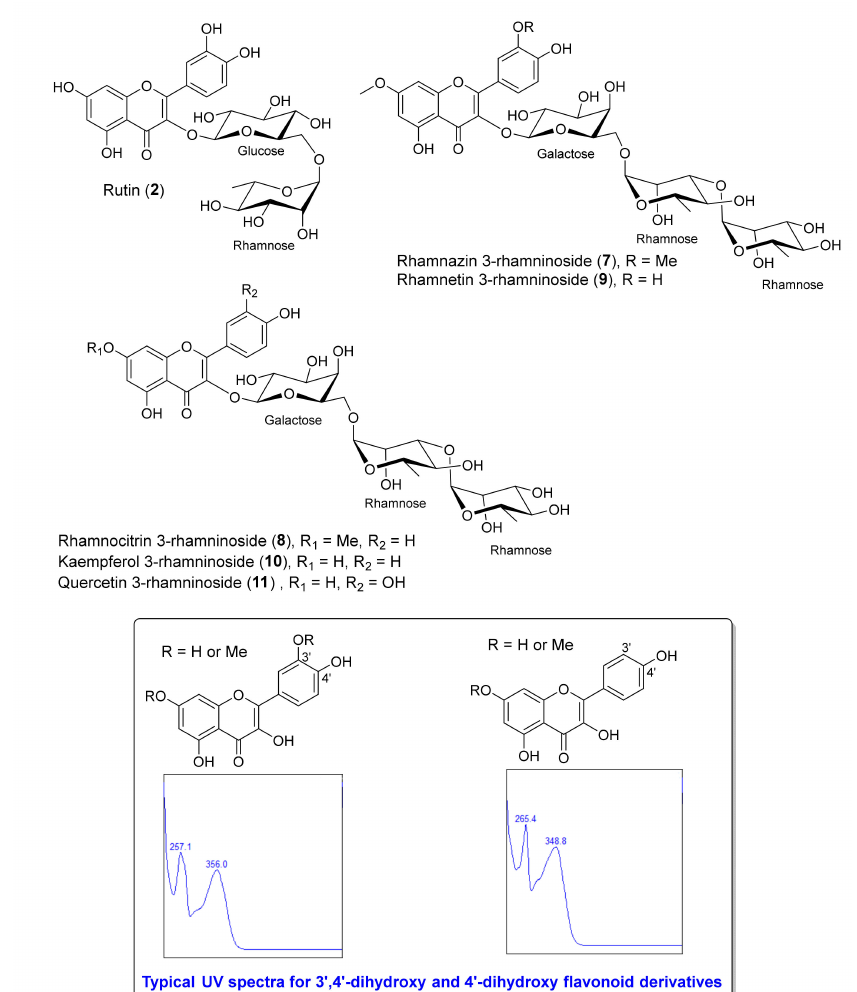
Figure 3. Structures of a standard flavonol glycoside, rutin ( 2 ) and flavonol glycosides 7 – 11 ; and typical UV spectra for 3 (cid:48) ,4 (cid:48) -dihydroxy and 4 (cid:48) -dihydroxy flavonoid derivatives showing λ max at 356 nm and 348 nm,